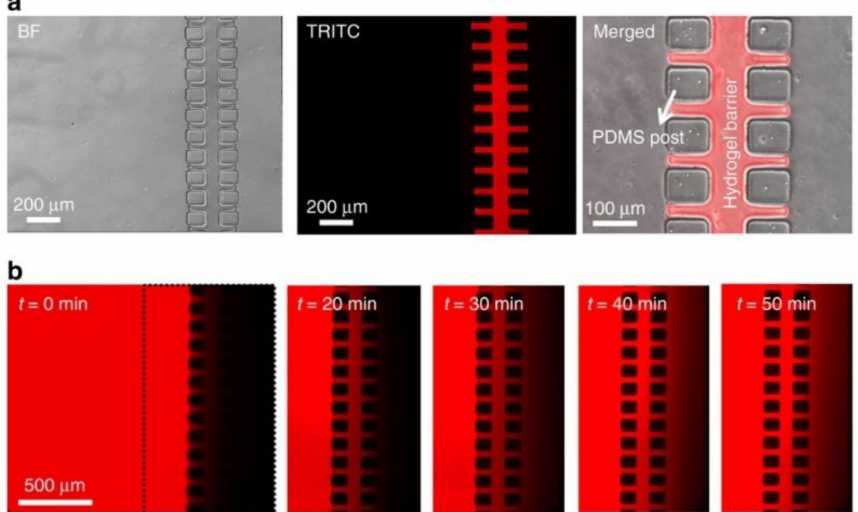
Figure 3. Bead-based sensors to analyze diffusion properties located in the microfluidic chambers for hydrogel barriers, reproduced from open access article Ref. [121] ( a ) The images show the results of bright-field and fluorescence, specifically showing inside the microfluidic device the fluorescently titled 5% poly(ethylene glycol) diacrylate (PEGDA)/20% 20k poly(ethylene glycol) (PEG) hydrogel barrier. ( b ) Inside the microfluidic device, 5% PEGDA/20% 20k PEG hydrogel barrier has 75 kDA TRITC-dextran diffused through it. The picture on the left shows a TRITC-dextran (2.5mgmL − 1 in phosphate-buffered saline (PBS)) solution flow through the cell culture chamber and hydrogel barrier into the sensing chamber, seen in the picture on the